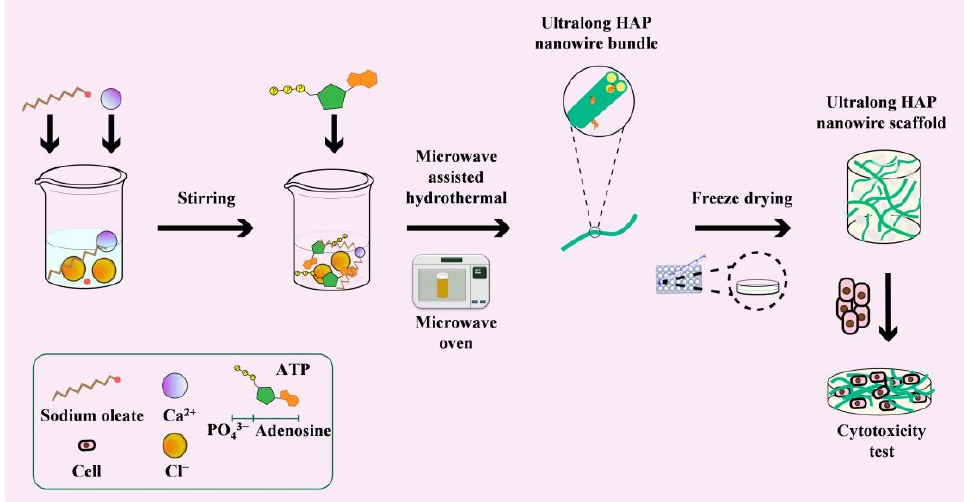
Figure 1. Schematic diagram for the rapid synthesis of ultralong HAP nanowires by the calcium oleate precursor microwave hydrothermal method using ATP as a bio-phosphorus source, and the preparation of the ultralong HAP nanowire porous scaffold.